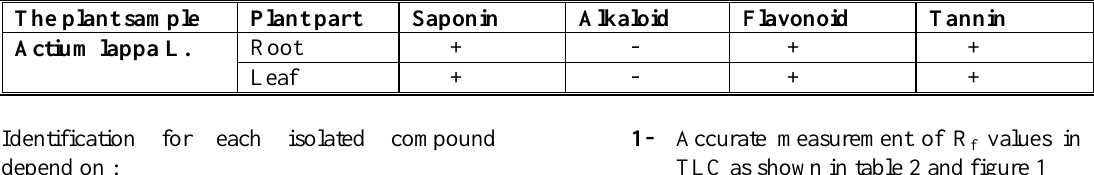
Table 1: The results of the general screening by chemical tests.